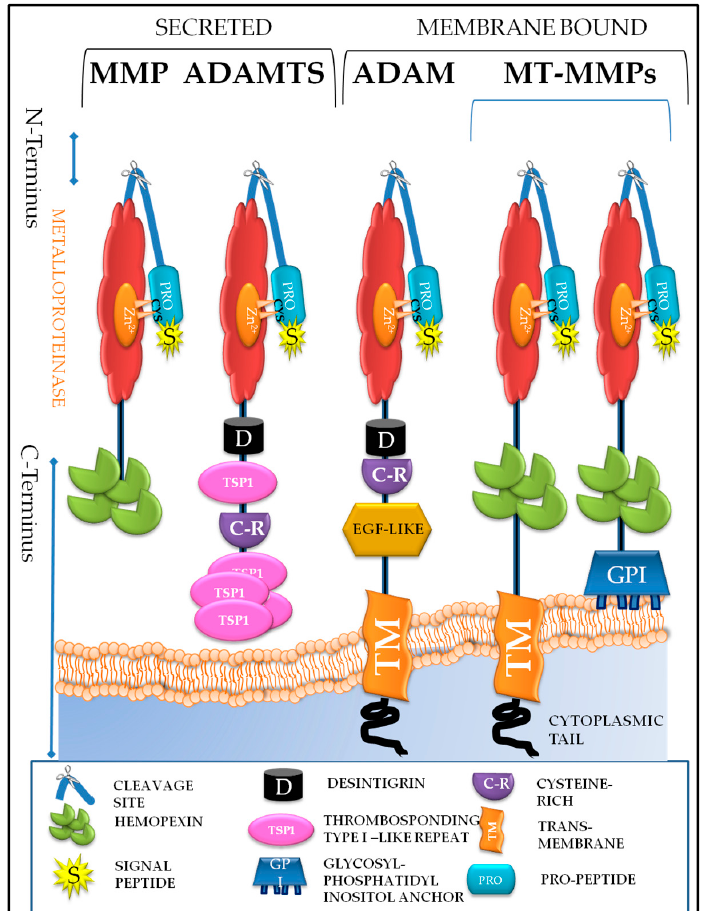
Figure 2. Schematic diagram of metzincins in human biology. The metzincin family members are characterized by their N-terminal domain structure. They have a signal peptide, a propeptide domain (containing a conserve ‘cysteine switch’), a flexible hinge region (cleavage site) and a zinc dependent catalytic domain (metalloproteinase). However, the C-terminal domain is what makes them unique; secreted MMPs contain a hemopexin-like domain that modulates substrate recognition. Membrane bound MMPs have either a GPI or a trans-membrane domain attached to a cytoplasmic tail that helps them to anchor to the plasma membrane of cells. ADAMs are membrane bound proteins that have disintegrin domain, a transmembrane domain, a cysteine-rich domain, and epidermal growth factor (EGF)-like domain and a cytoplasmic domain. ADAMTS also have a disintegrin domain. However, unlike ADAMs, they are secreted proteins and their disintegrin domain is linked to a central thrombospondin type I-like repeat, a cysteine-rich domain and varying numbers of thrombospondin